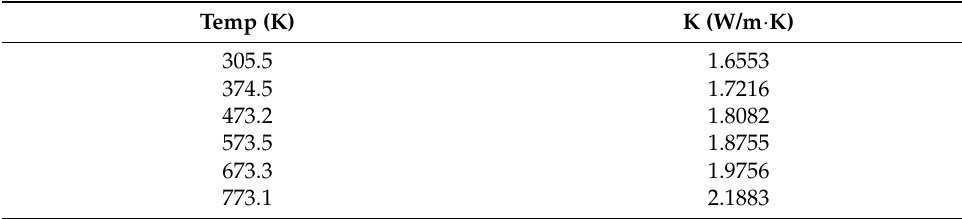
Table 2. Thermal conductivity of C12A7 electride at different temperatures.